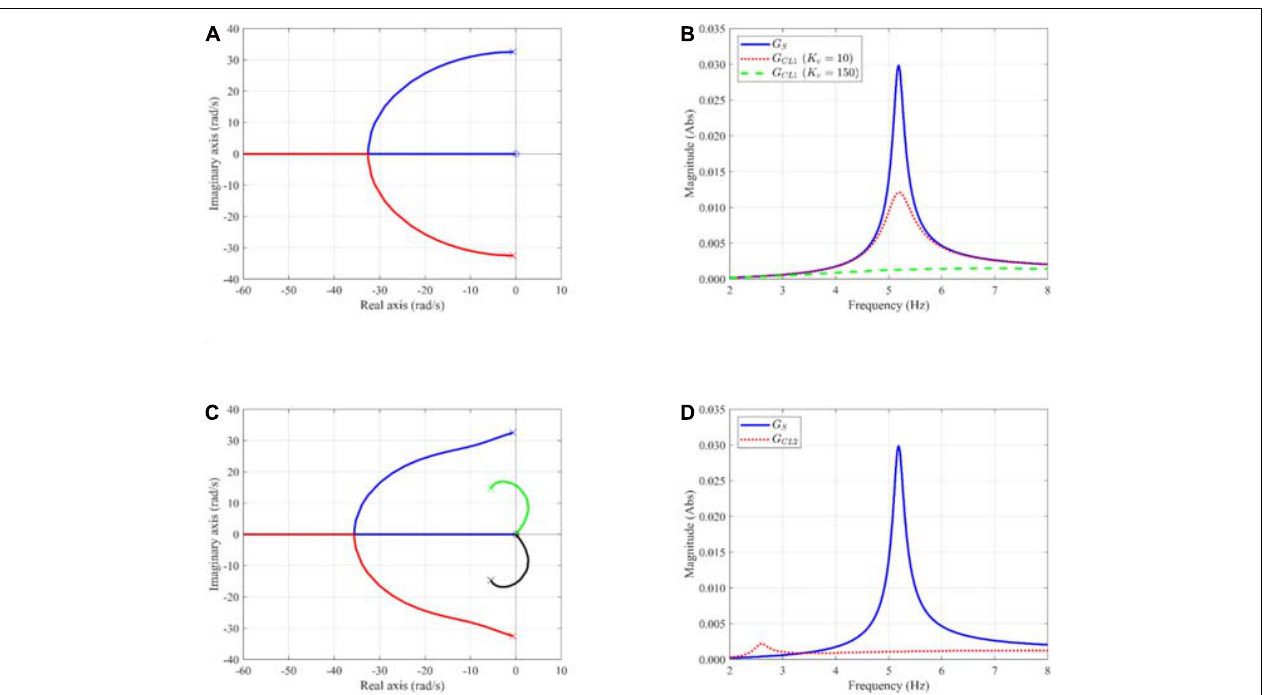
FIGURE 9 | AVA without HSI and ASI: (A) Root locus of an ideal actuator, (B) TFs of an ideal actuator for two control gains ( K v = 10 and K v = 150), (C) Root locus of a real actuator, and (D) TFs of a real actuator. Symbols: ( × ) pole, (o) zero.